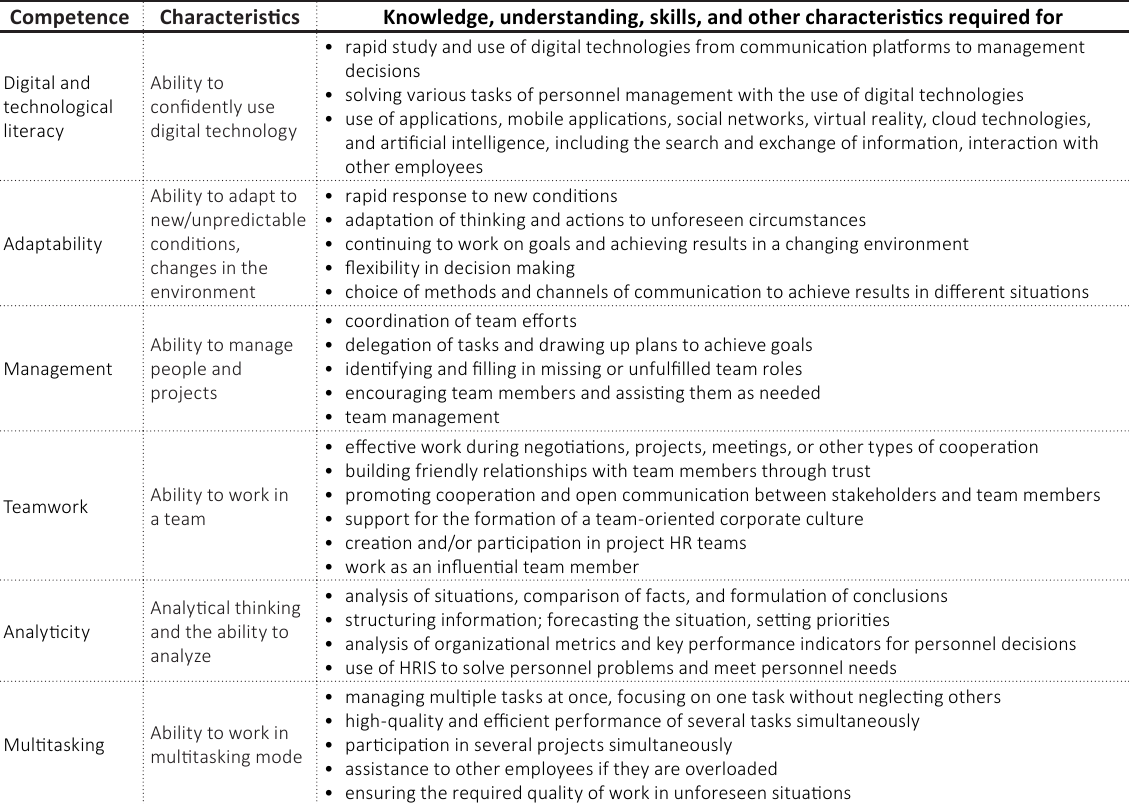
Table 1 (cont.). Transferable competencies of personnel